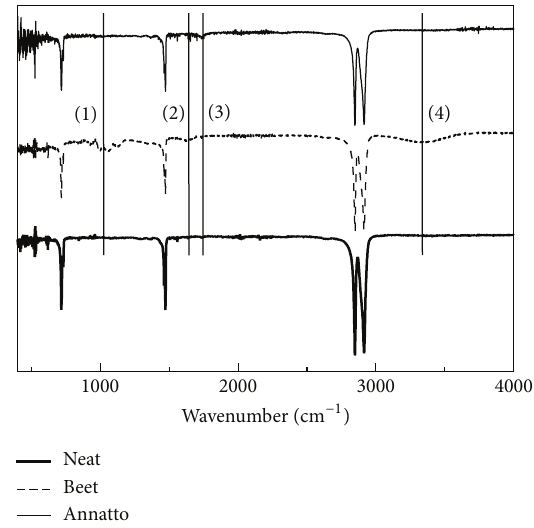
Figure 6: Powder’s spectra from neat UHMWPE, UHMWPE with annatto, and UHMWPE with